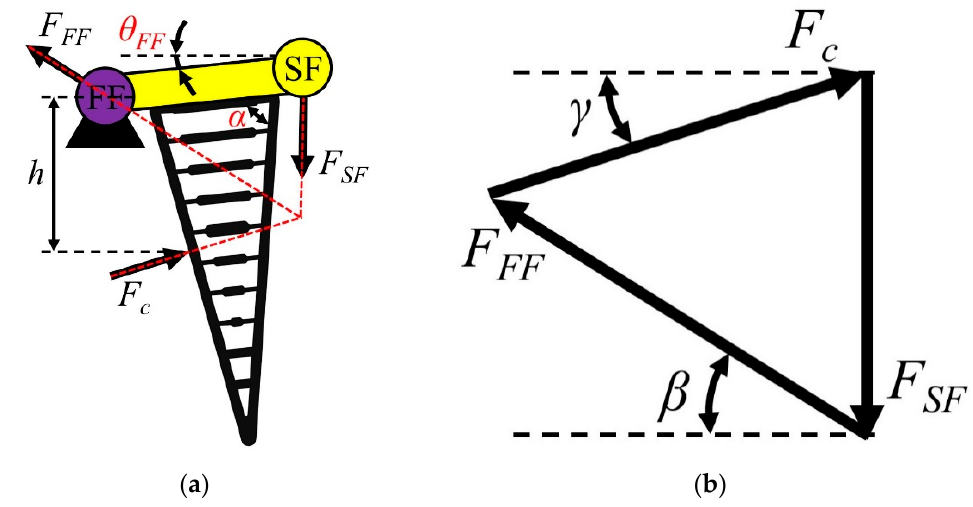
Figure 7. Force analysis of the finger and its connector: ( a ) force diagram; ( b ) closing force triangle. According to Equations (4) and (5), To maintain the force balance of the finger and its connector, one obtains